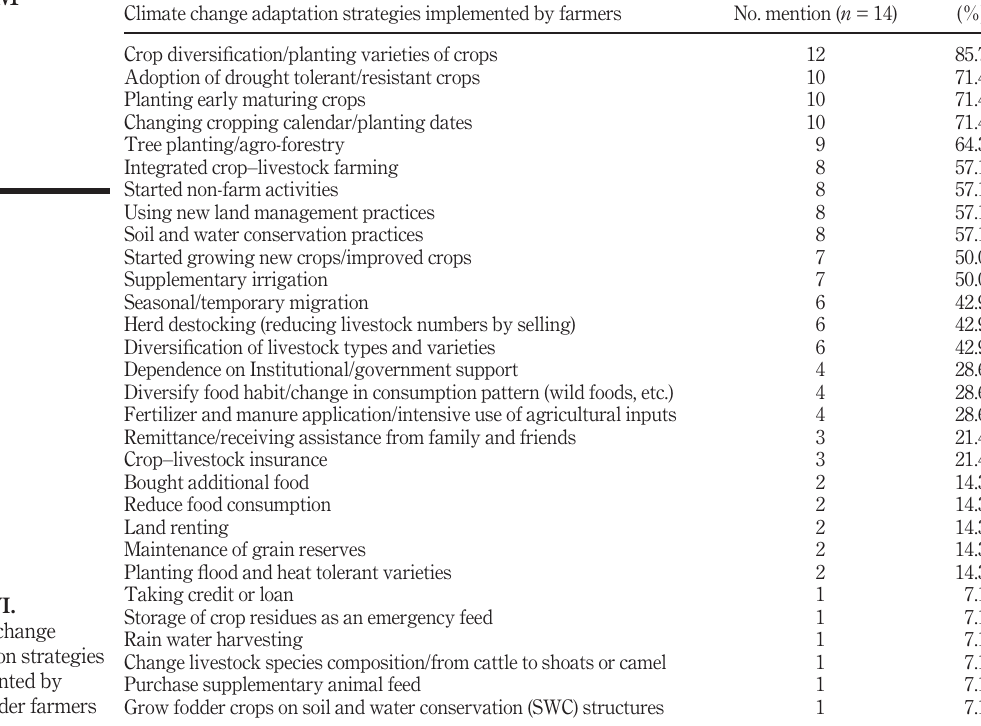
Table VI. Climate change adaptation strategies implemented by smallholder